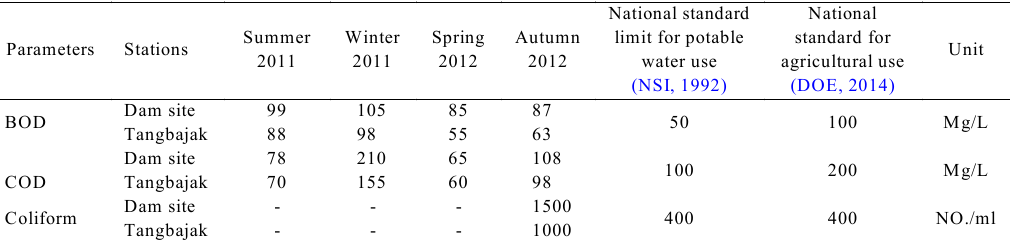
Table 7: Chemical quality test results of Gavi